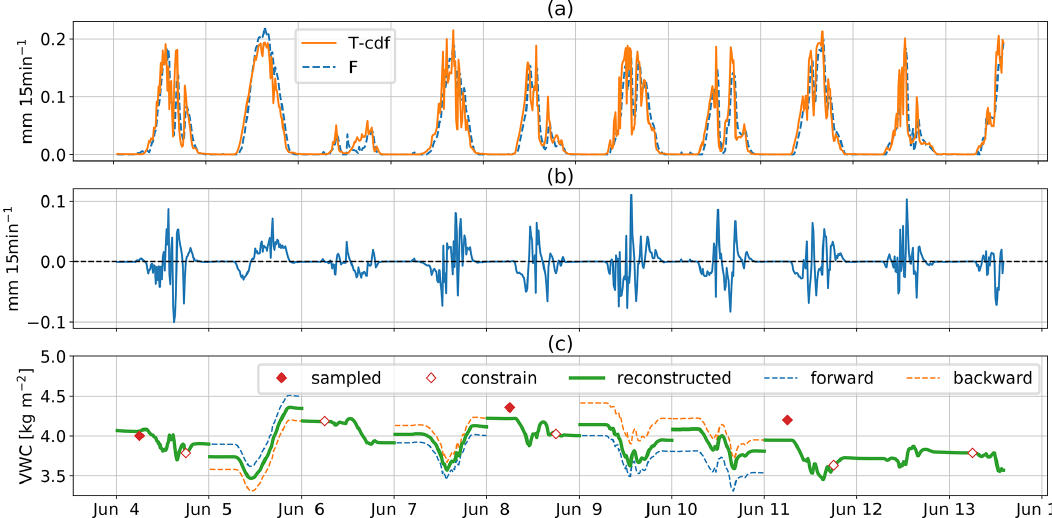
Figure 8. A 10d reconstruction of VWC, with (a) sap flow ( F ) and estimated transpiration (ET 0 -cdf). (b) The difference between sap flow and transpiration and (c) the sampled and reconstructed VWC is shown. In between sampling days, VWC estimates are the weighted average between forward and backward reconstructions from the consecutive sampling days (based on the time to the closest sampling day). The measurements which are used to constrain the reconstructed line are accentuated with open